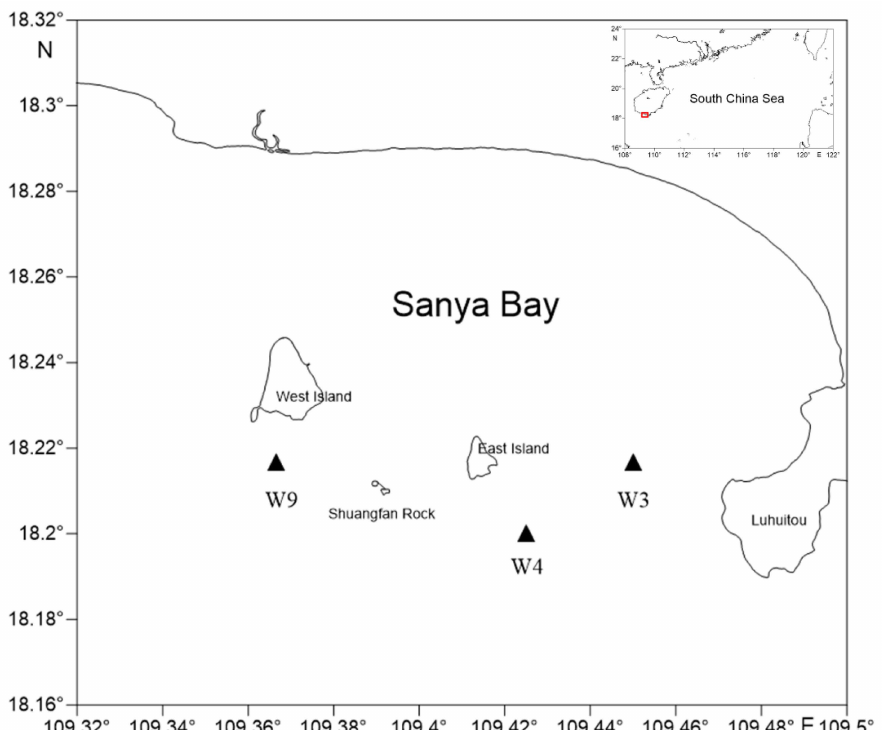
Figure 1. Sampling stations in Sanya Bay separately visited on July and October,